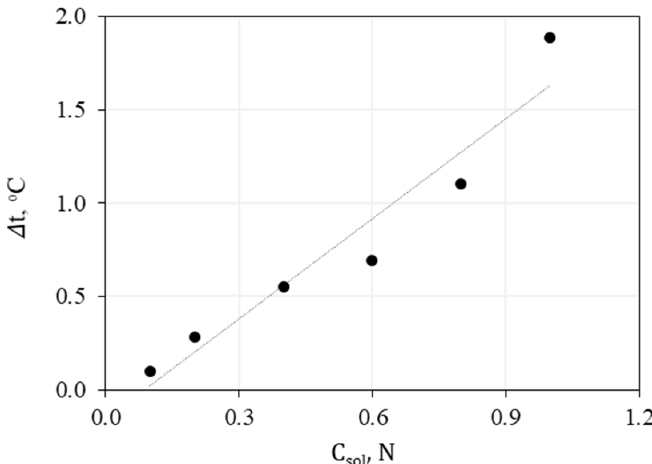
Figure 8. Maximum temperature decrease ( Δ t = t in − t min ) in frozen hydrate-saturated sand as a function of NaCl concentration (C sol from 0.1 to 1.0 N; t in = − 6.5 ◦ C, p = 0.1 MPa). Note that the cooling rate (V t , ° С /h) likewise increased considerably with the salinity increase (Figure 9): from 0.4 ° С /h for 0.1 N to 4.7 ° С /h for 1.0 N, which is an increase of more than 10 times.